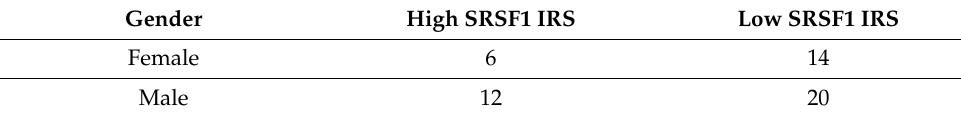
Table 3. Distribution of gender according to SRSF1 immunoexpression.